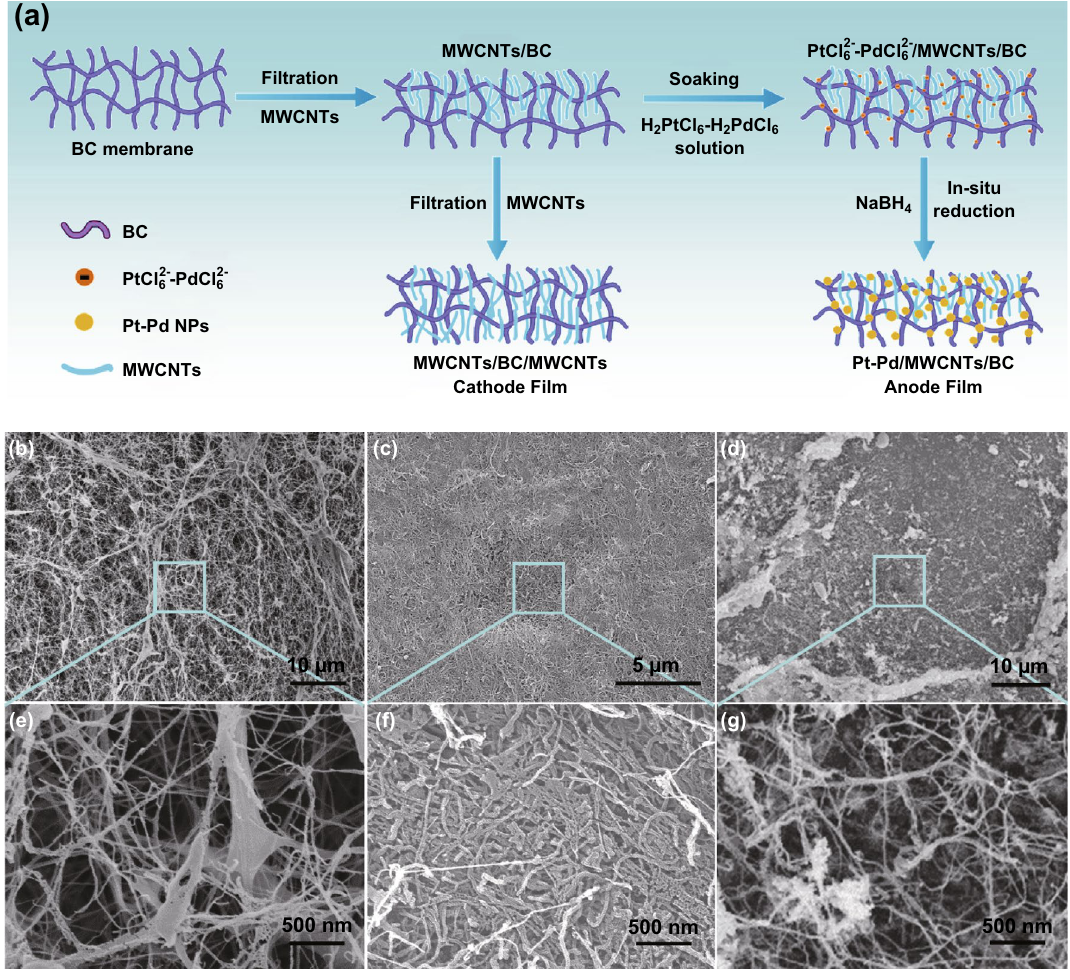
Fig. 3 a Preparation process of cathode and anode films of GFC. b, e Surface micromorphology of original BC membrane. c, f Surface mor‑ phology of MWCNTs filtrated into BC membrane. d, g Micromorphology of Pt–Pd nanoparticles (NPs) on the surface of MWCNTs/BC